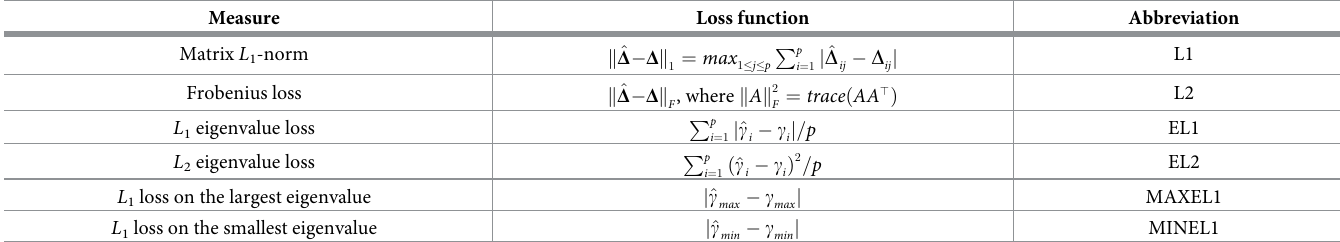
Table 1. Loss functions used in the synthetic data analysis to assess the numerical accuracy of the B-net and D-net estimates. Measure Loss function